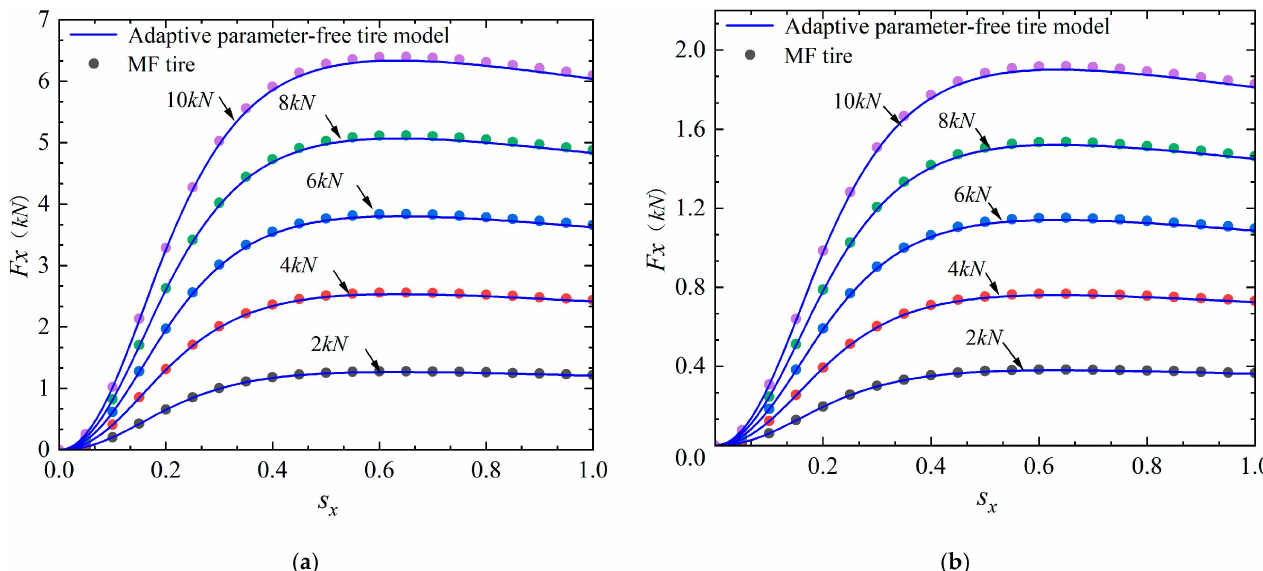
Figure 6. Longitudinal force contrast curve. ( a ) µ = 0.9. ( b ) µ = 0.3. Comparing the two data groups with the root mean square error result, the root mean square is Formula (17), and its RRMSE value is less than